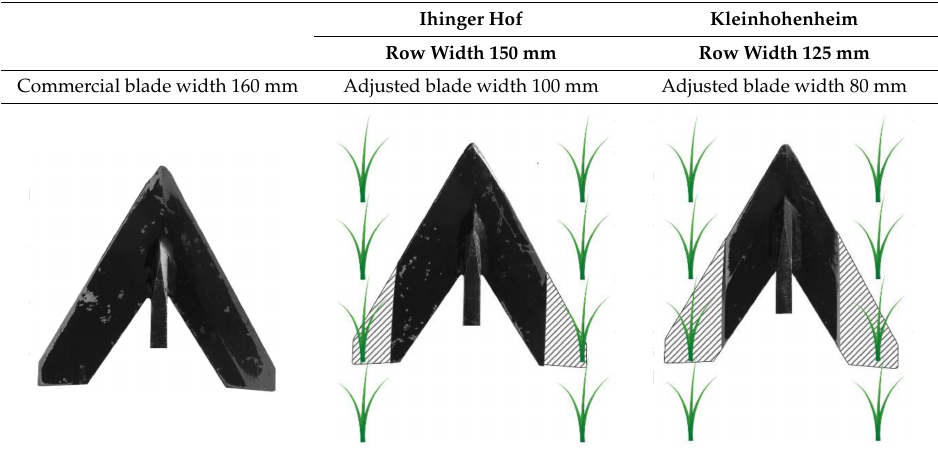
Table 2. Top view of the commercial and the adjusted no-till sweeps to the narrow row widths of 150 and 125 mm at Ihinger Hof and Kleinhohenheim, respectively. Hatched lines symbolize the area cut off from the commercial 160 mm wide no-till sweep. The plants left and right of the sweeps symbolize cereal